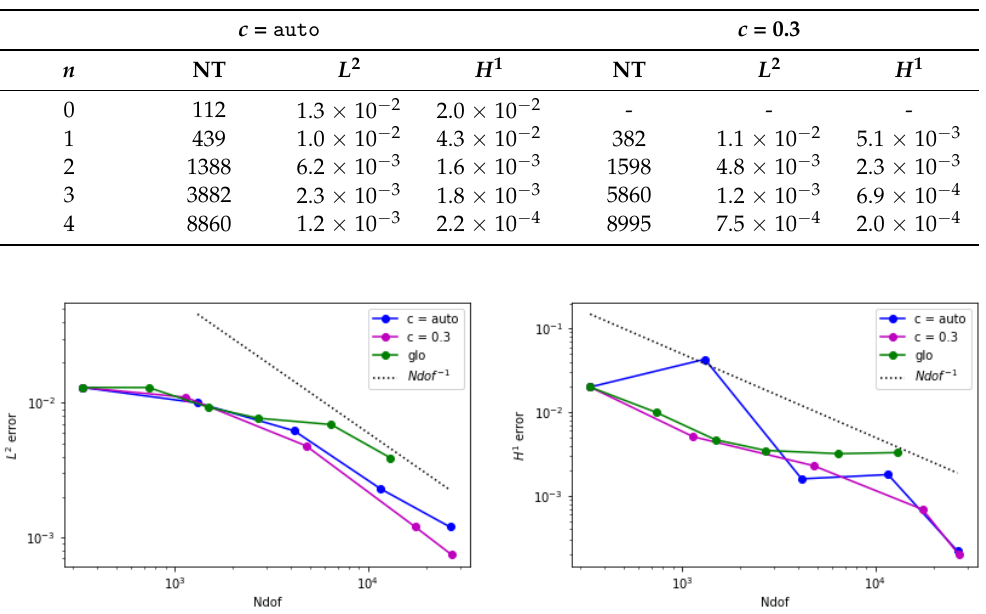
Figure 4. Error behavior for example 1 when η R is adopted. ( Left ) The estimated L 2 norm of the error is displayed. ( Right ) The estimated H 1 seminorm of the error is shown.